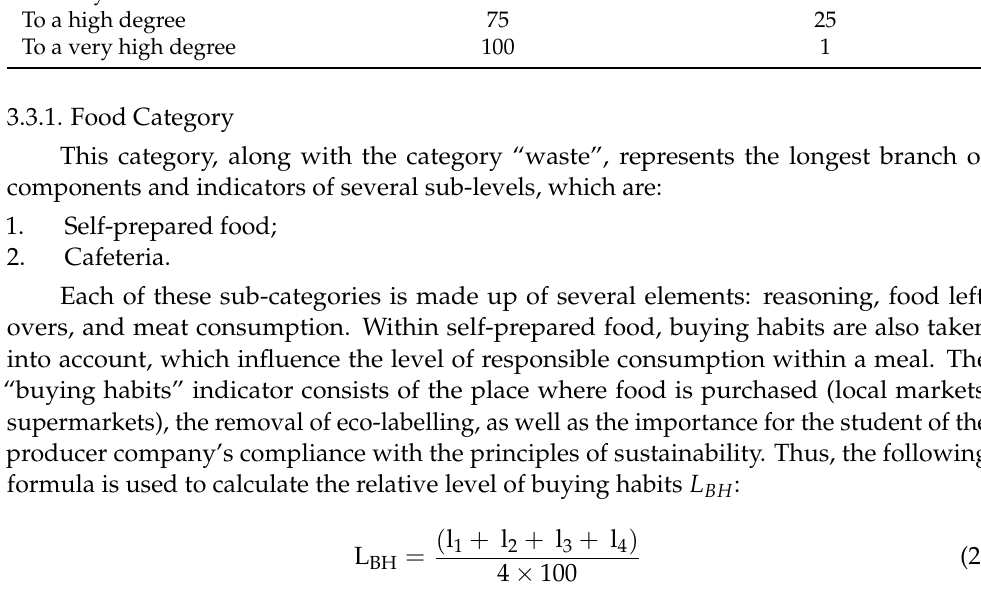
Table 1. Correspondence between semantic and numerical values of indicators. Semantic Value Direct Numerical Value Reverse Numerical Value To a very small degree 1 100